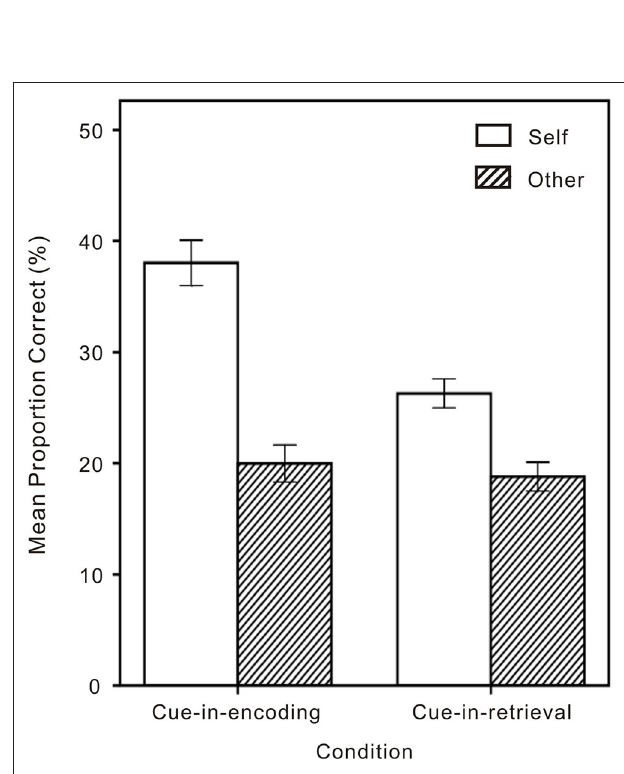
FIGURE 3 | Memory performance on Self and Other trials in the cue-in-encoding and the cue-in-retrieval conditions. Error bars represent one standard error from the